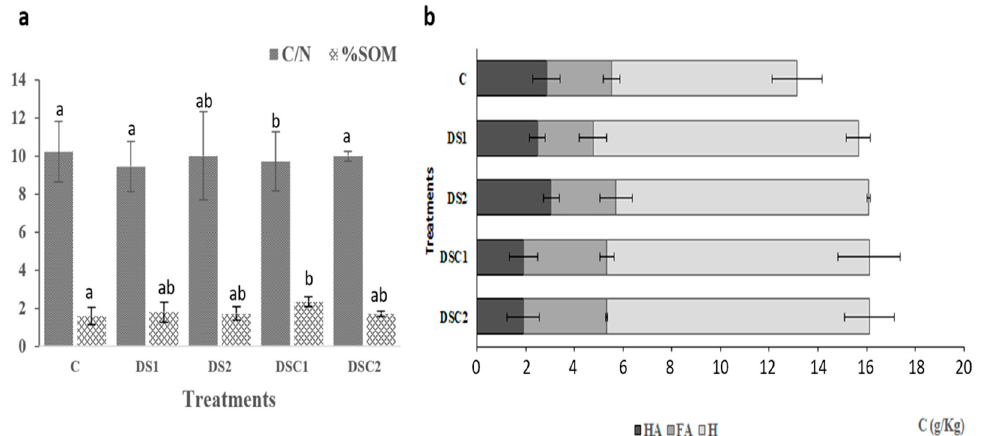
Figure 1. Changes in % SOM and C/N ratio ( a ) and soil humic substances (g C kg − 1 ) (humic acids (HA), fulvic acids (FA), and humin (H)) ( b ) after the application of raw and composted de-inking paper sludge for two years. With C: Control without amendments; DS1: soil amended with raw de-inking sludge at 30 t ha − 1 ; DS2: soil amended with raw de-inking sludge at 60 t ha − 1 ; DSC1: soil amended with composted de-inking sludge at 20 t ha − 1 ; DSC2: soil amended with composted de-inking sludge at 40 t ha − 1 . For each parameter, sample mean values with the same letters are not statistically different at p ≤ 0.05. Table 2. Changes in soil chemical properties after the application of raw and compost de-inking paper sludge for two years.